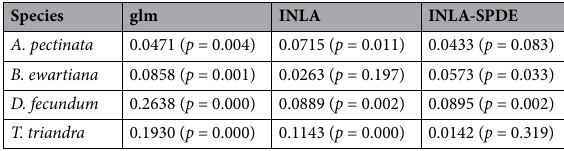
Table 1. Moran’s I test statistics by species and model type.